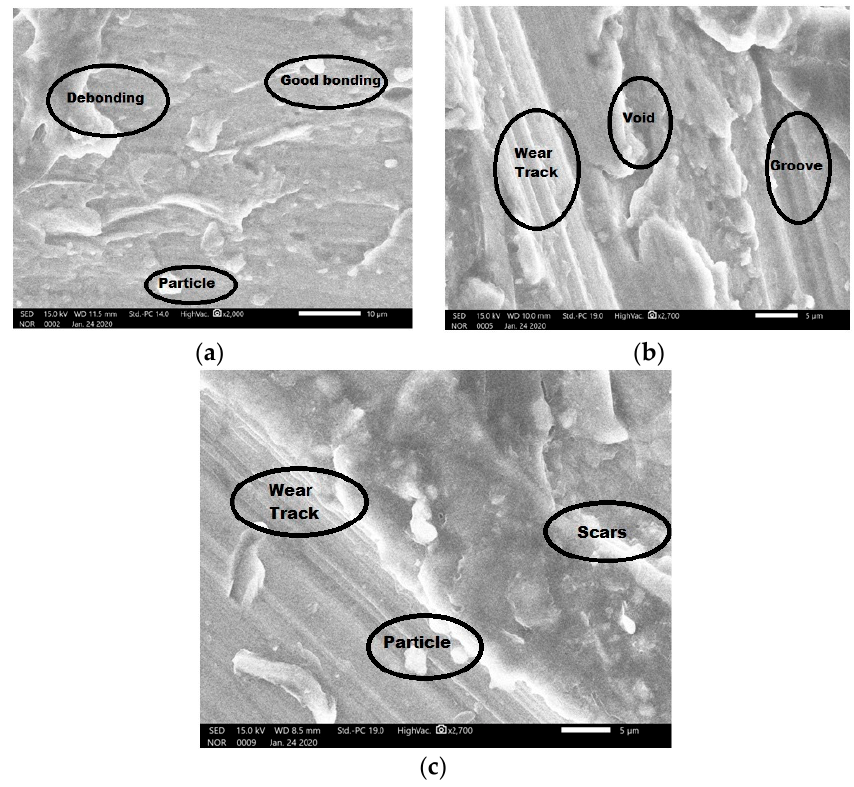
Figure 9. SEM images of wear samples ( a ) SP1, ( b ) SP2 and ( c ) SP3.